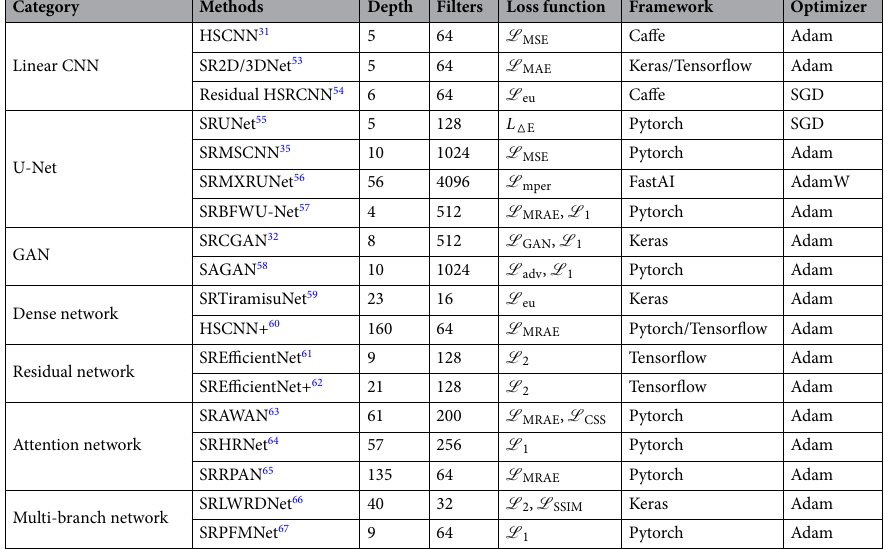
Table 3. Overview of data-driven deep learning methods. Depth is the number of convolutional layers. Filters the number of convolution kernels. Framework is the original platform used in the references without excluding the usage of any other framework. The loss functions are defined in the Supplementary